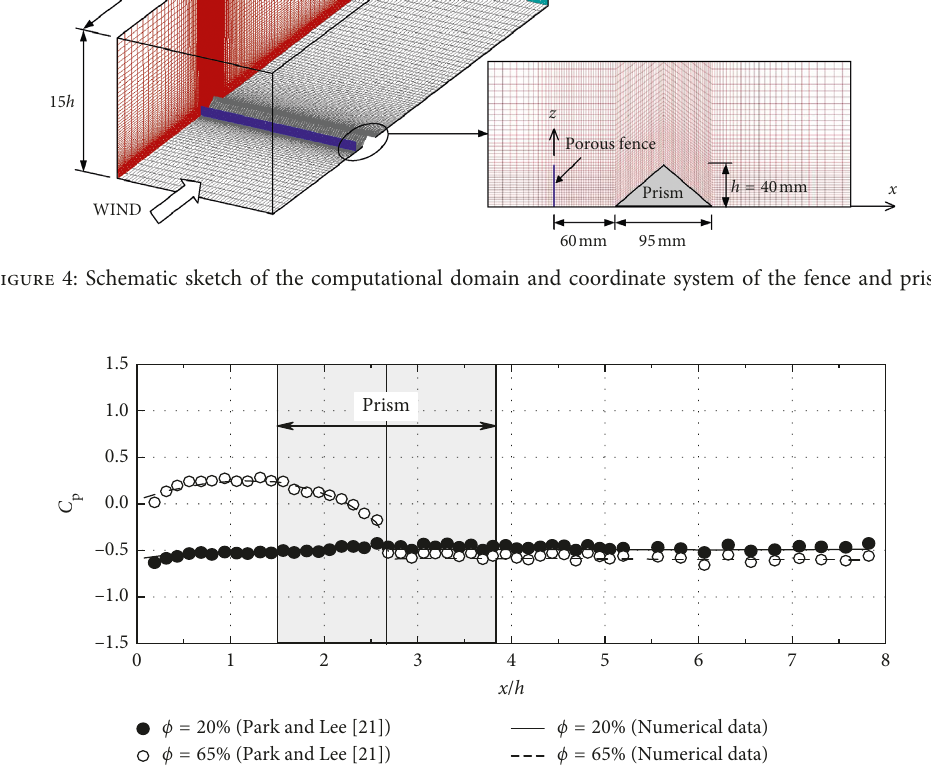
Figure 5: Comparison of the simulated and measured pressure distributions on the prism model and ground surface along the midspan of the fence.